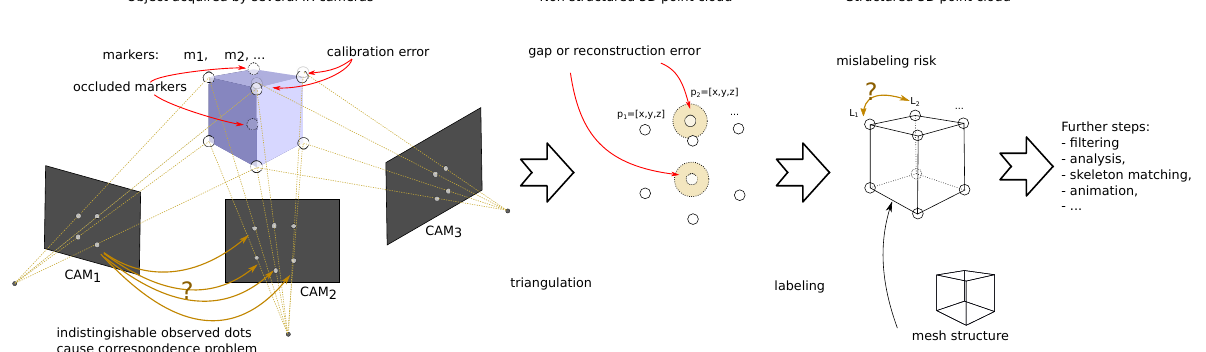
Figure 1. Processing in the early stages of the motion capture pipeline with distortion sources (red) and problems to solve (yellow), question marks (?) indicate ambiguous choices.